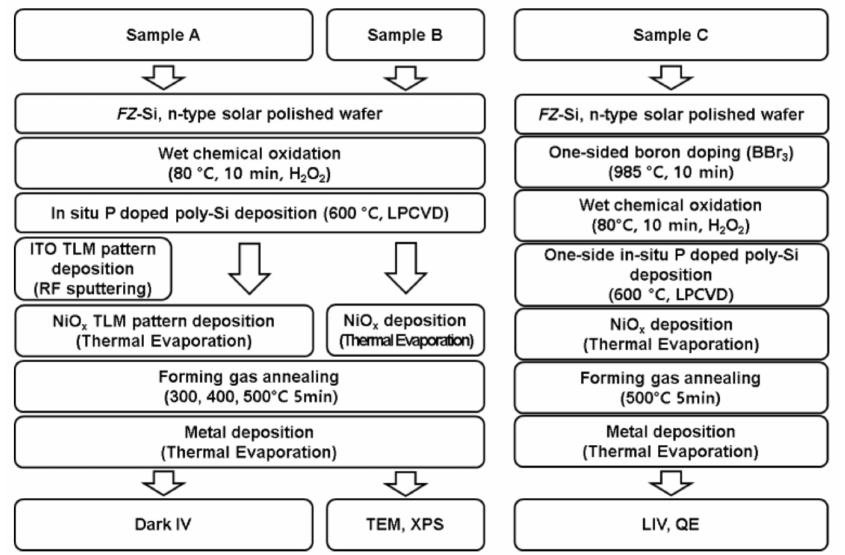
Figure 2. Schematic of process flow for the fabrication of sample A, B, and